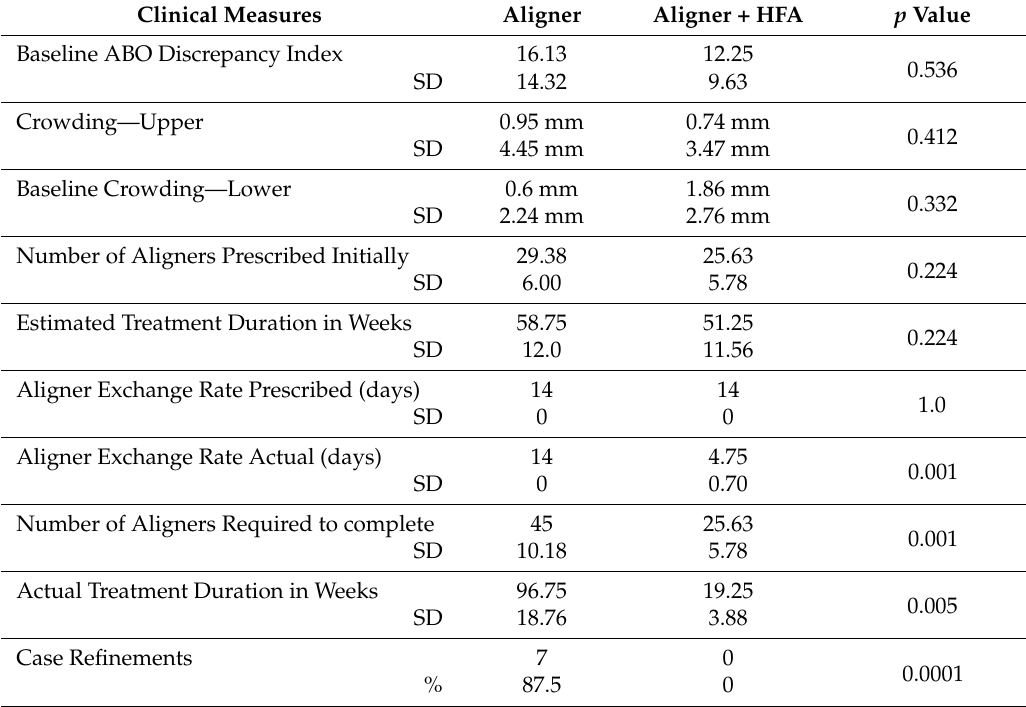
Table 2. Comparative